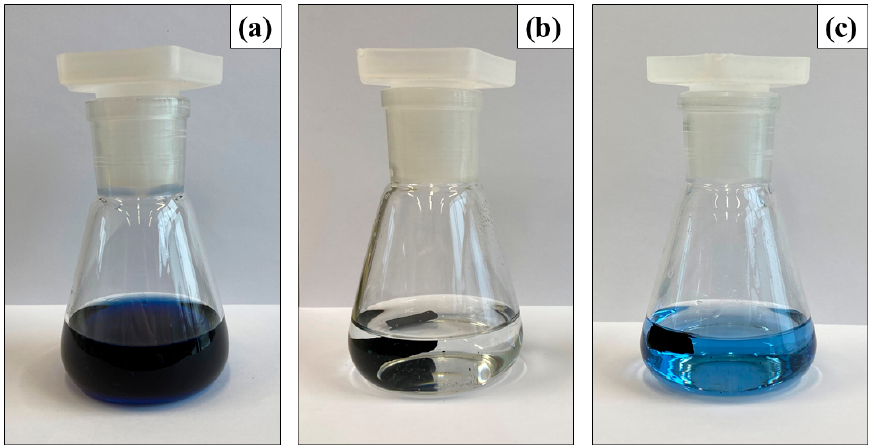
Figure 5. Photos of Reactive Black 5 solutions ( a ) before adsorption and after ≈ 23 h of adsorption with 52 mg of ( b ) PPy-G-BaFe aerogel, prepared at the 10 wt% BaFe fraction, and ( c ) PPy-G aerogel.